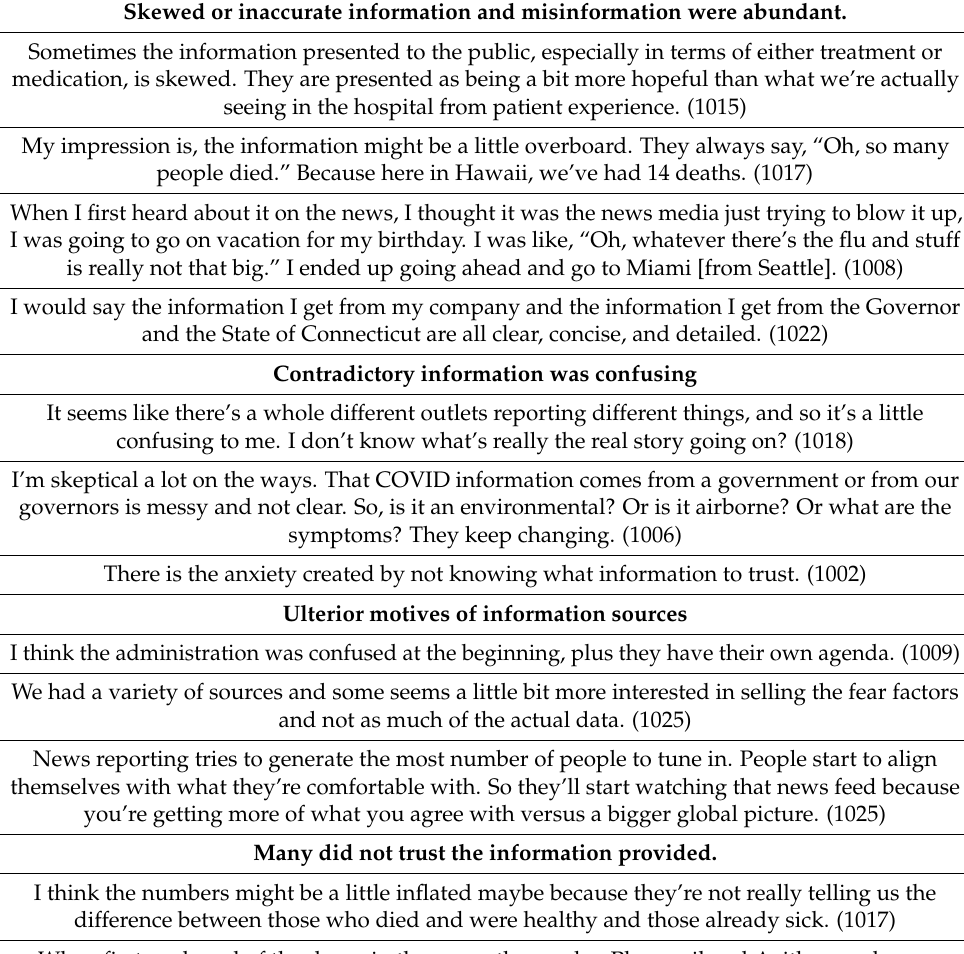
Table 3. Themes and quotes related to the quality of